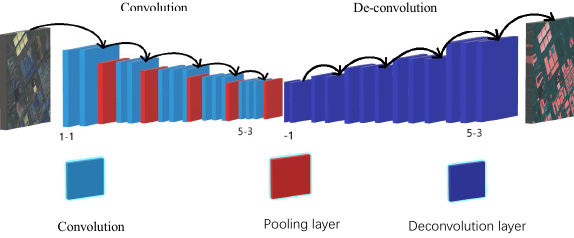
Figure 4. Cascade full convolution neural network structure